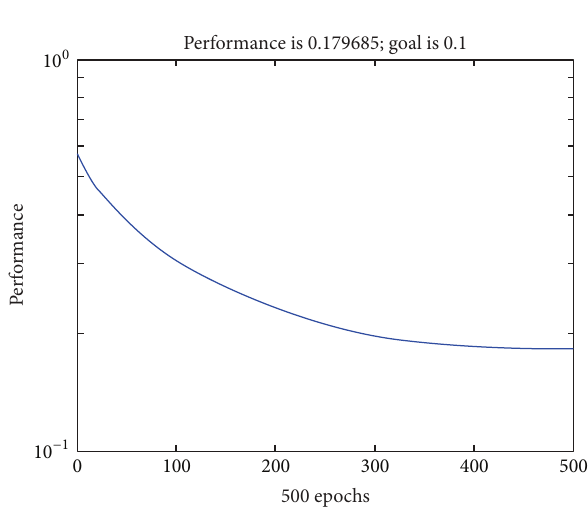
Figure 5: Learning result.